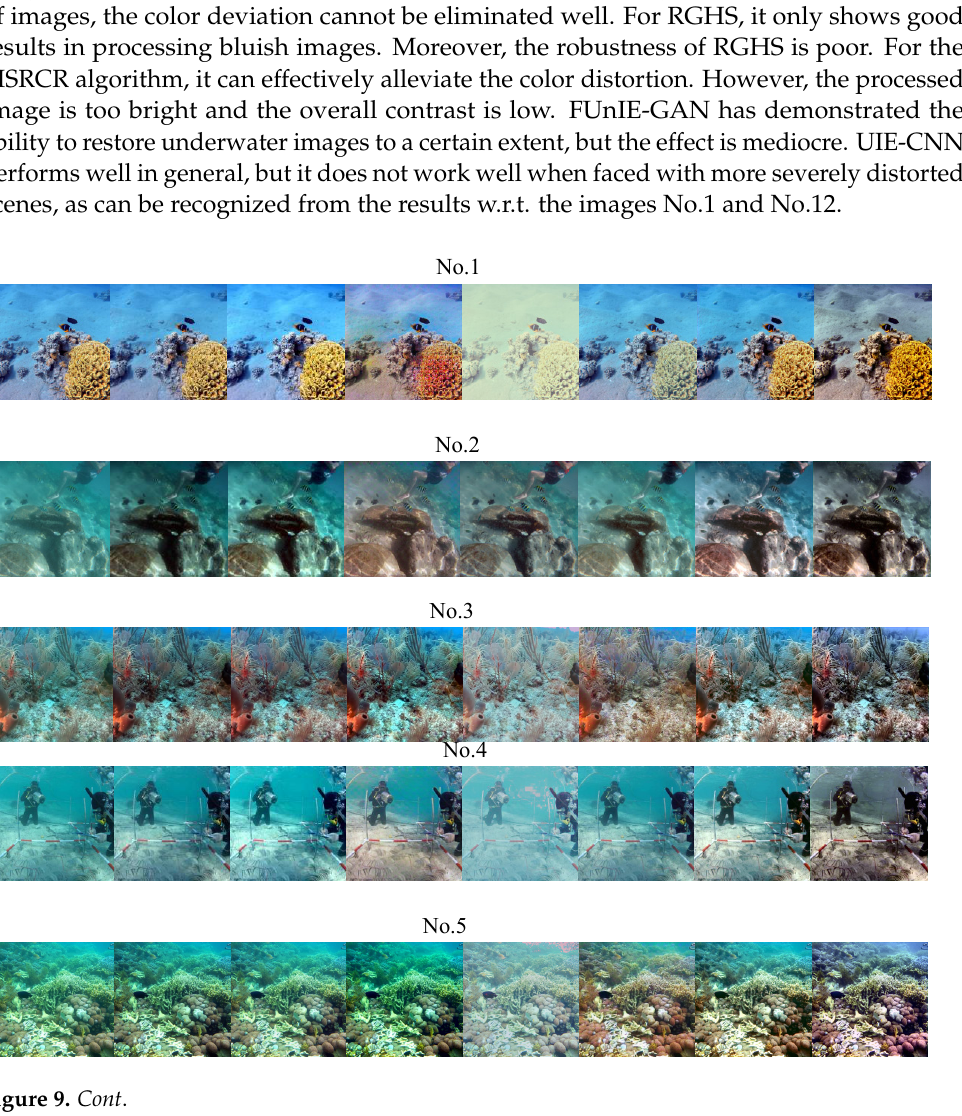
Figure 8. CLAHE algorithm. ( a ) Original underwater image; ( b ) after defogging, and ( c ) after